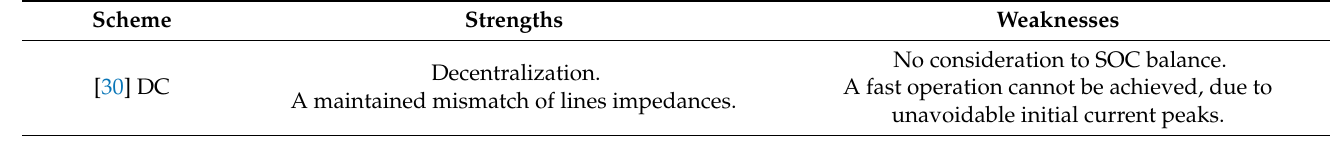
Table 1. Summary of decentralized control